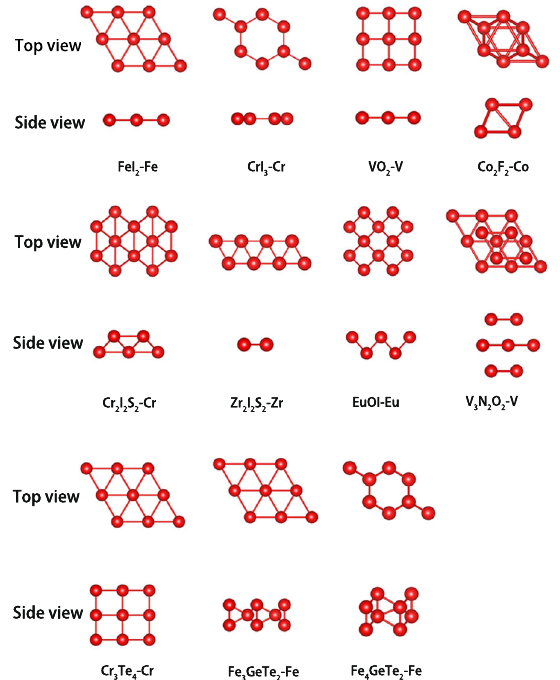
Fig. 1 The structure prototypes of 2DFM materials with only magnetic atoms